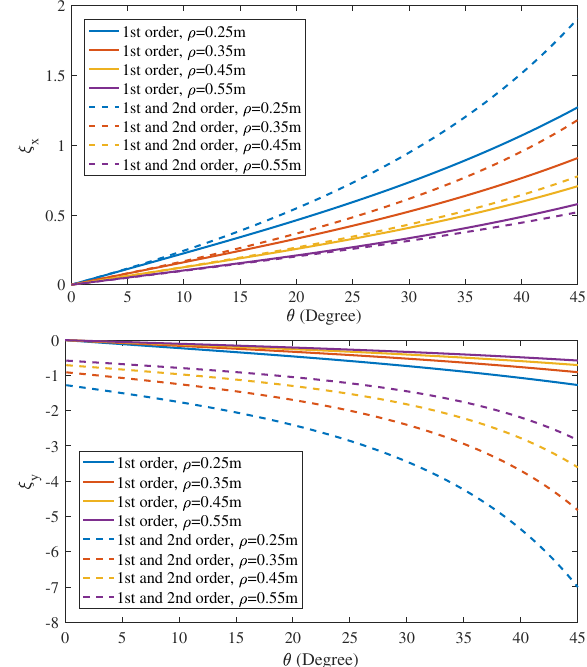
FIG. 2. Relation between the edge angle and chromaticity ¼ 1 m and α ¼ 1 . The chromaticity is multi- assuming β x;y x;y plied by 4 to account for the 4 edges located at nonzero dispersion sections.